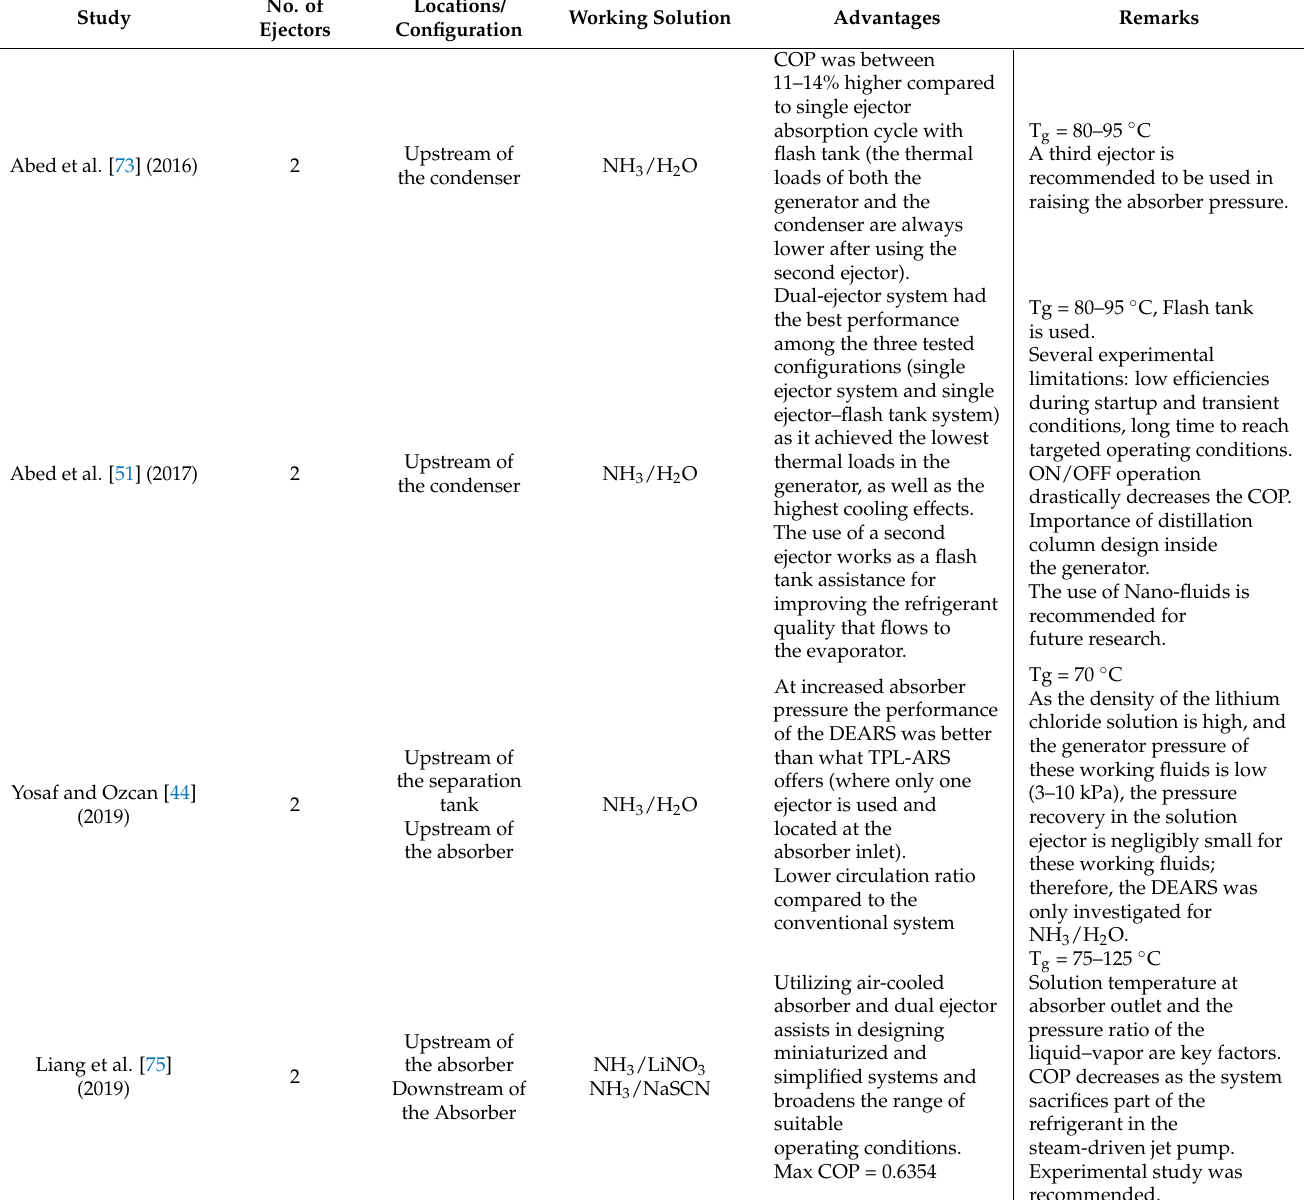
Table 1. Summary of the studies on dual-ejector absorption refrigeration systems reported in the